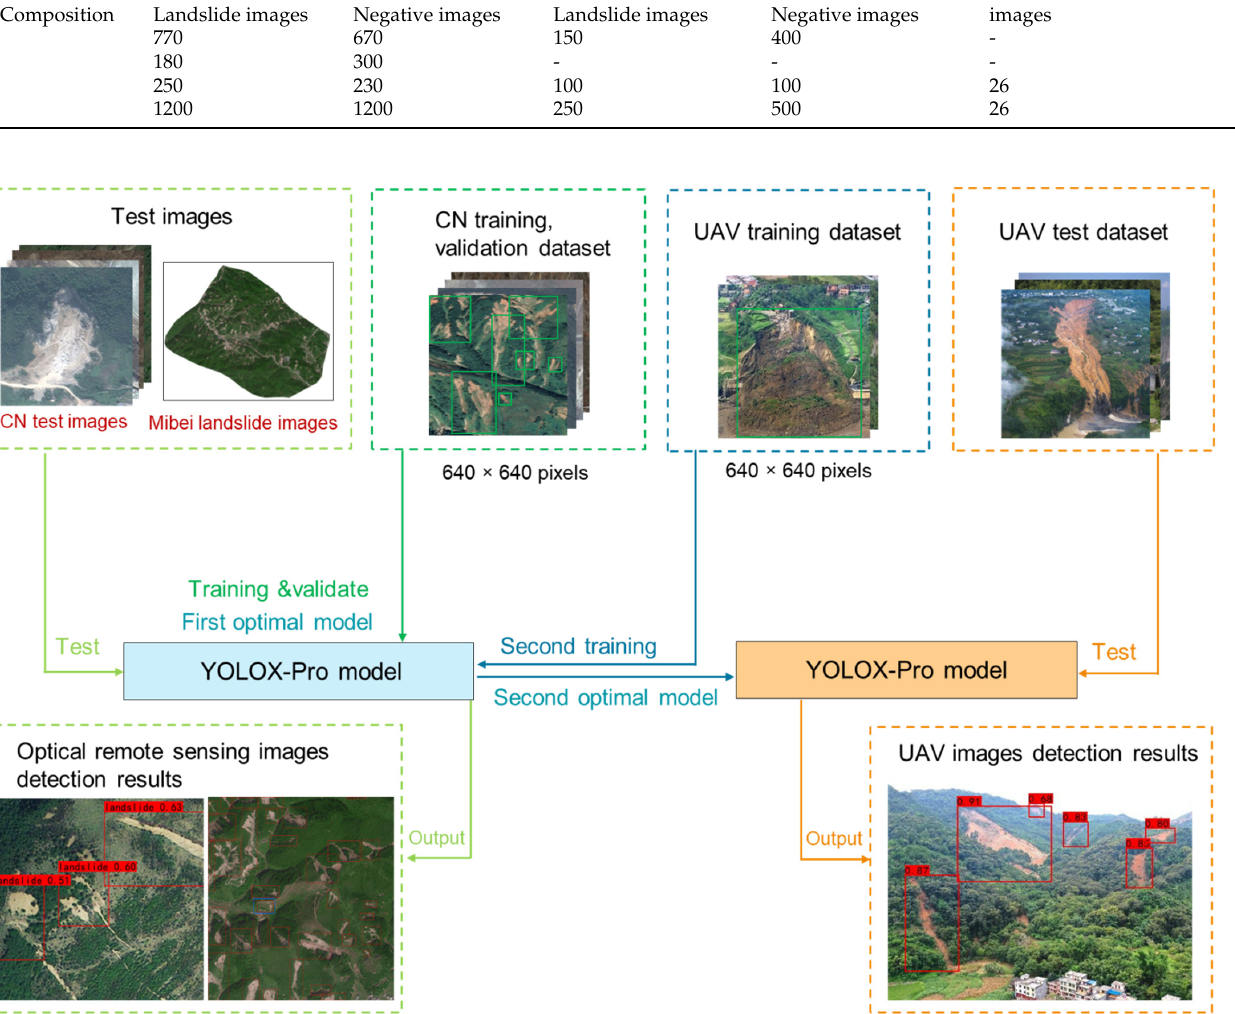
Figure 11. The workflow of landslide detection from CN dataset, UAV dataset, and Mibei landslide area. Table 3. The details of dataset division. The UAV dataset does not have validation set. The Mibei landslide area is only divided into test set for landslide detection.